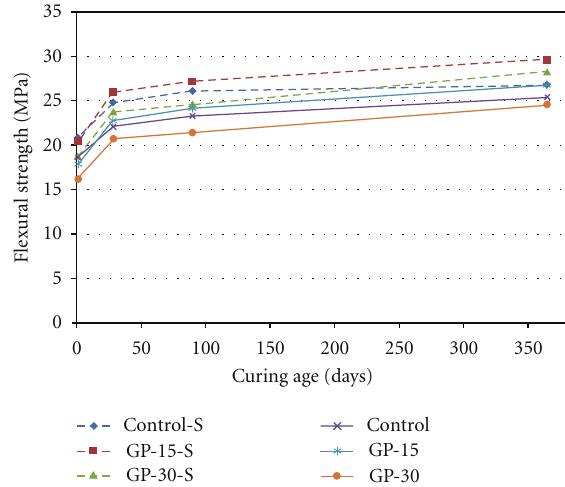
Figure 4: E ff ect of both GP and r-FA on compressive strength of UHPFRC with and without steam curing.